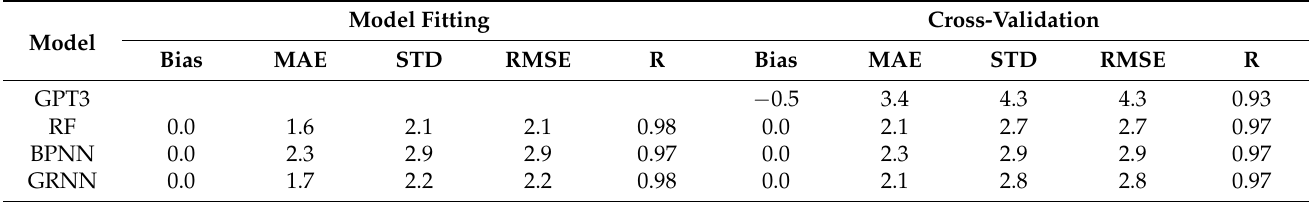
Table 1. Model fitting and cross-validation performances of different